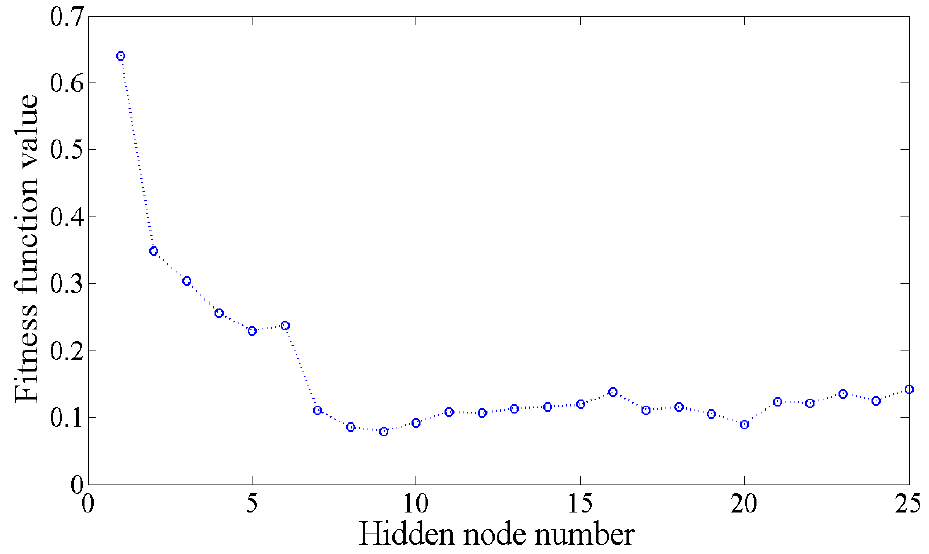
Figure 10. Variations in the 5-fold cross-validation data’s error levels due to the number of hidden nodes.